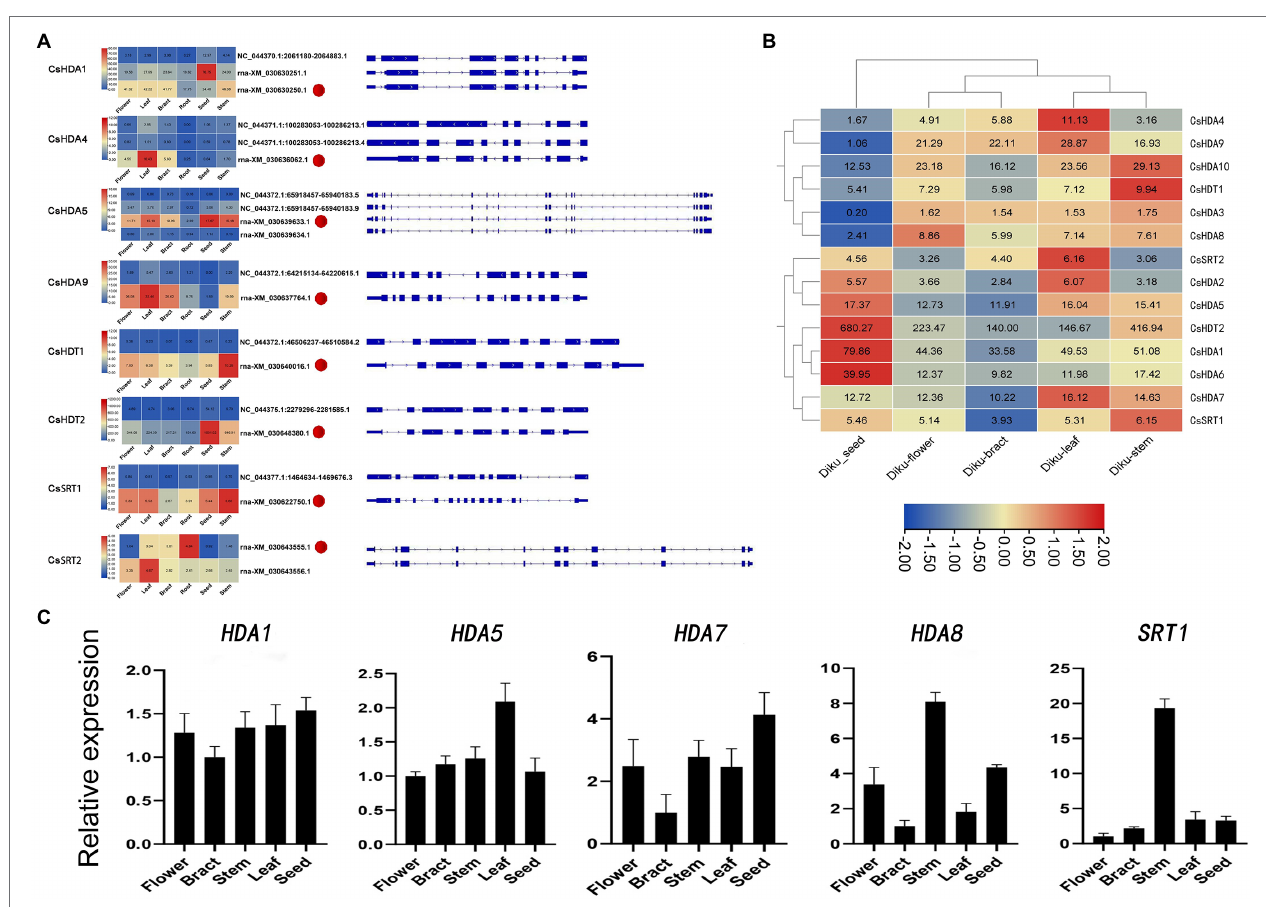
FIGURE 6 | (A) Alternative splicing isoforms and the expression pattern of eight CsHDAC genes. Red dots refer to the selected reference isoforms. (B) The gene expression profile of CsHDACs in the seed, flower, bract, leaf, and stem. The row scale on the values has been performed, and the FPKM value of each gene was presented in the figure. (C) Expression patterns of the selected CsHDACs genes in the flower, bract, stem, leaf, and seed. The characters on the x axis indicate different organs and tissues. The y axis shows the relative level of gene expression. The EF1- α gene was used as an internal